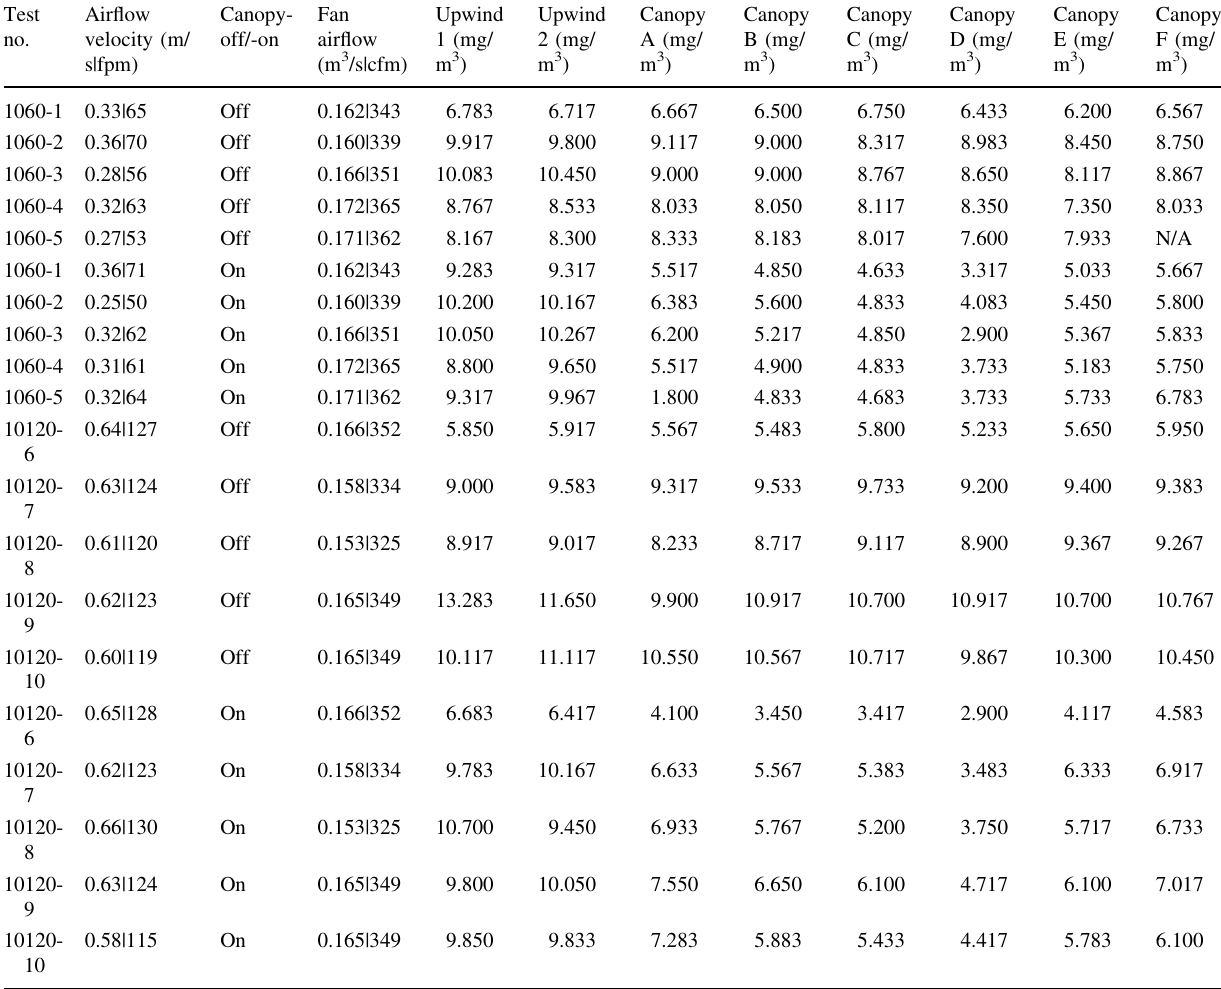
Table 5 Test data results for CAC at 10-in. height underneath the canopy using Small Fan #1 Test